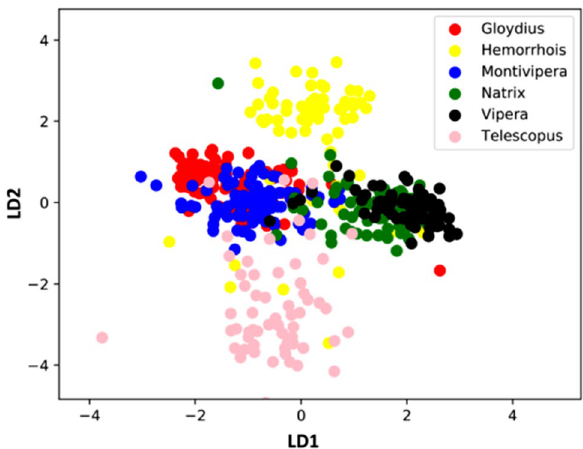
Figure 2. Scatterplot resulting from linear discriminant analysis (LDA) over the snake images.